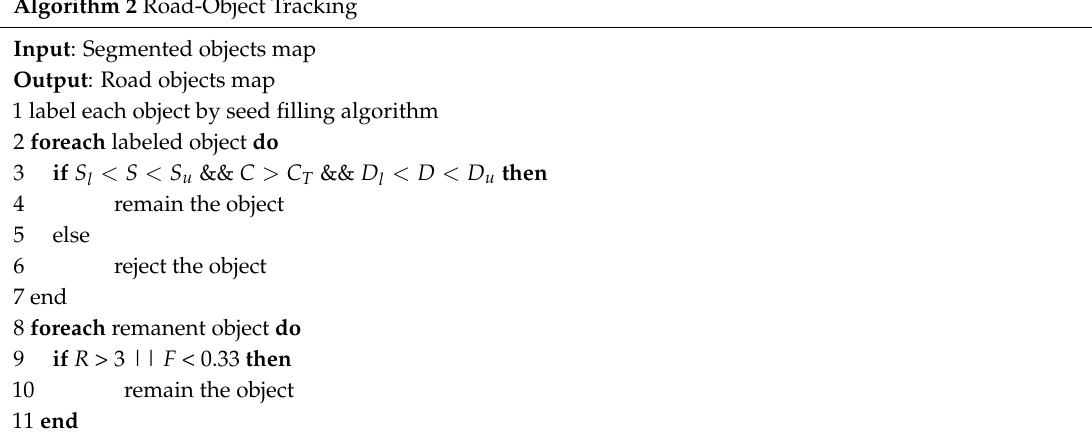
Algorithm 2 Road-Object